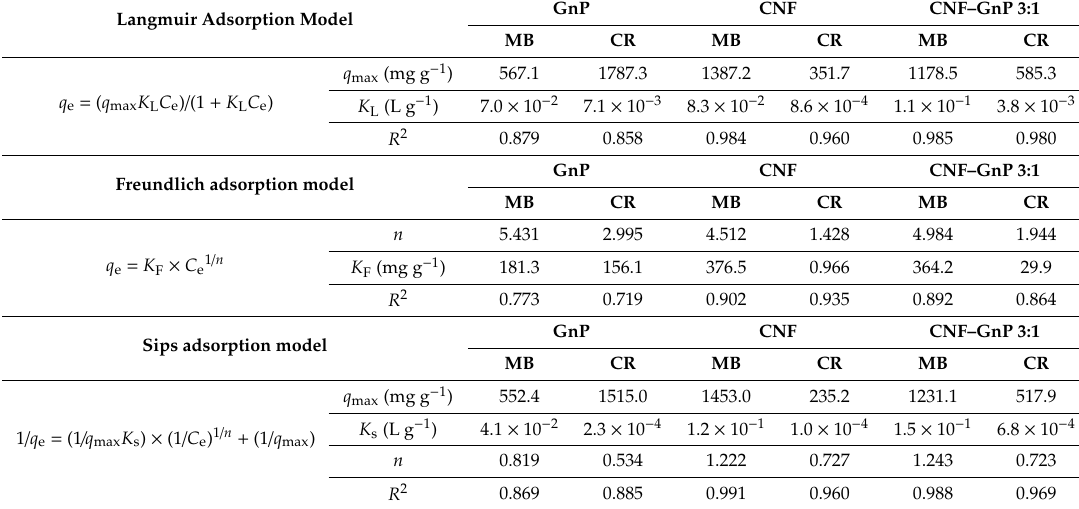
Table 2. Estimated adsorption parameters of Langmuir, Freundlich and Sips isotherms at room temperature.